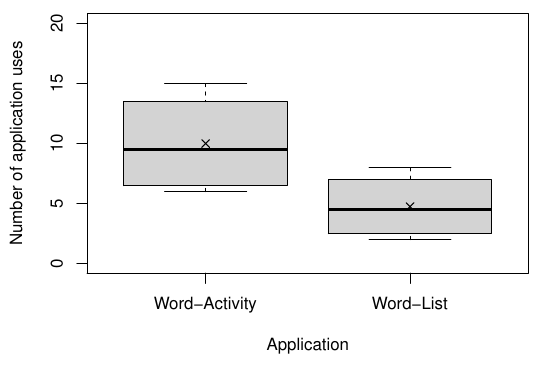
Figure 12. Number of application uses.